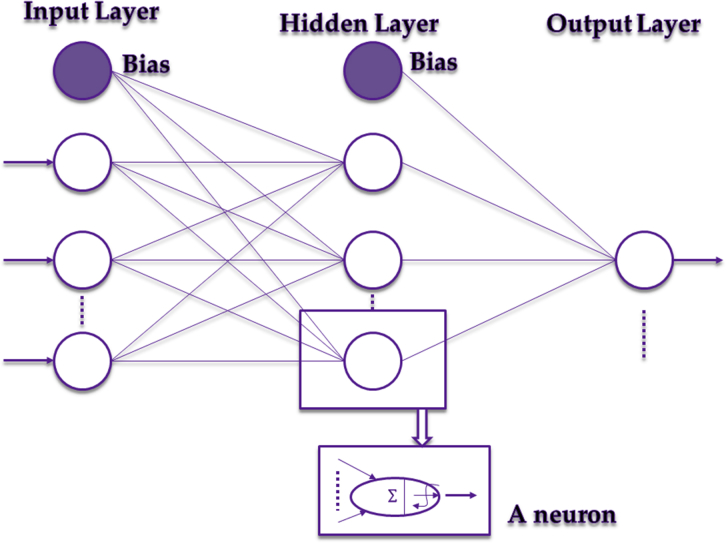
Typical structure of a multilayer feed-forward ANN [Adapted from Oyebode (2014)].